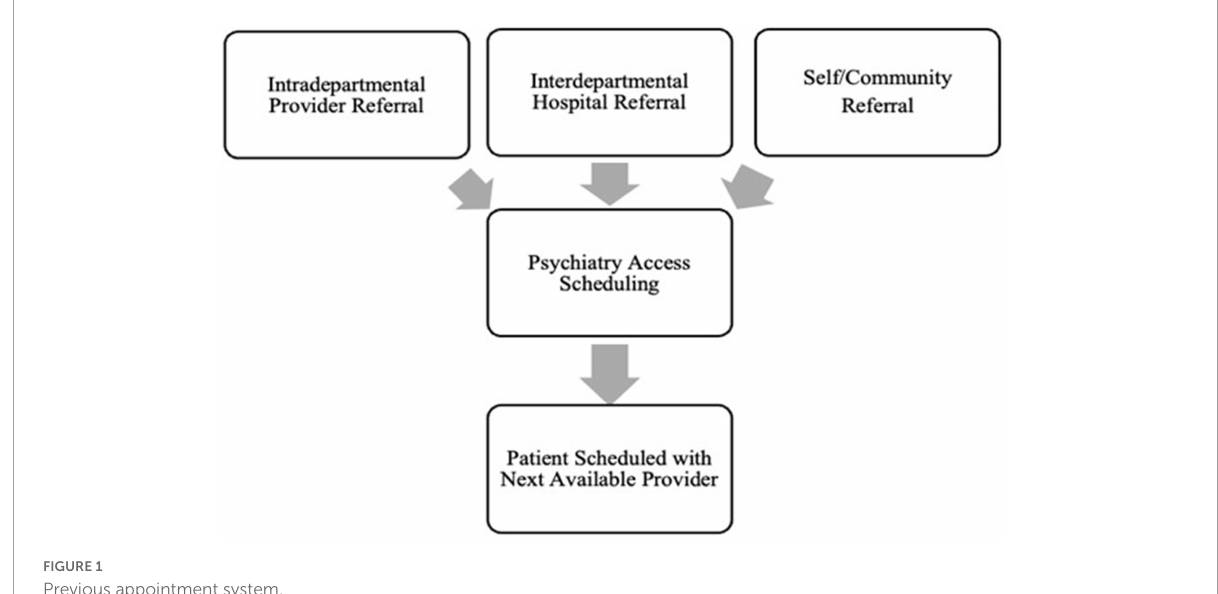
FIGURE1 Previous appointment system.